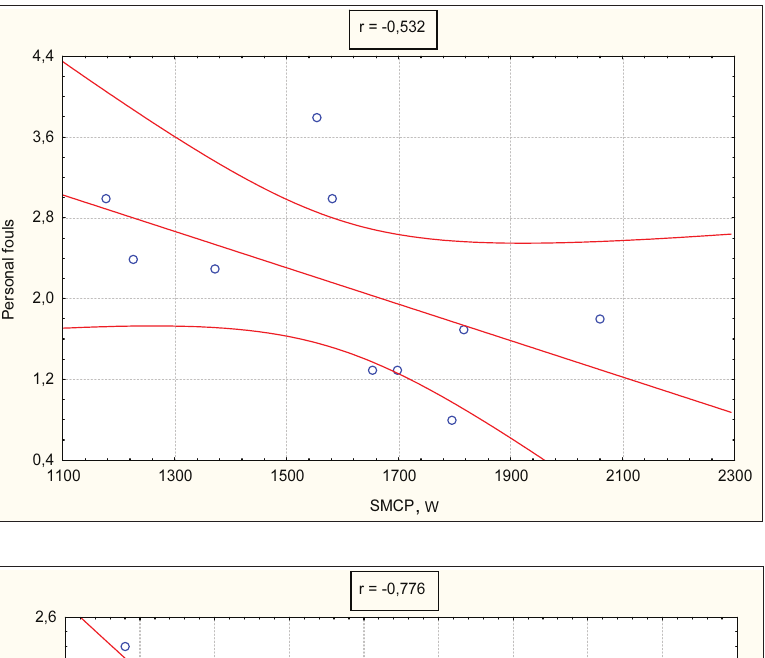
Figure 2. The correlation of the number of personal fouls and single muscular contraction power